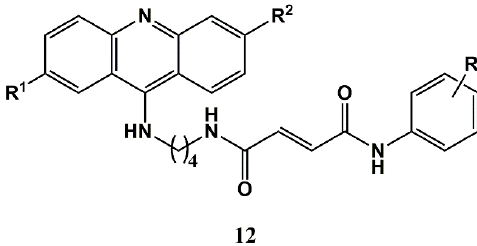
Figure 5 . 9-aminoacridine-cinnamic acid conjugates developed by Gomes and co-workers [64,65].